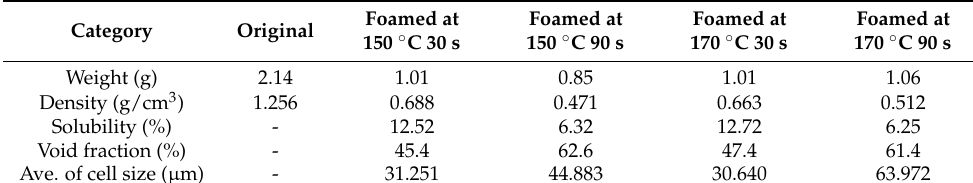
Figure 5. Specimens for high-frequency measurements: ( a ) Non-foamed; ( b ) Original; ( c ) Microcel- lular foamed at 150 °C and 30 s; ( d ) Microcellular foamed at 150 °C and 90 s; ( e ) Microcellular foamed at 170 °C and 30 s; ( f ) Microcellular foamed at 170 °C and 90 s. Table 4. Specifications of microcellular foamed ceramic urethane for high-frequency measurements.